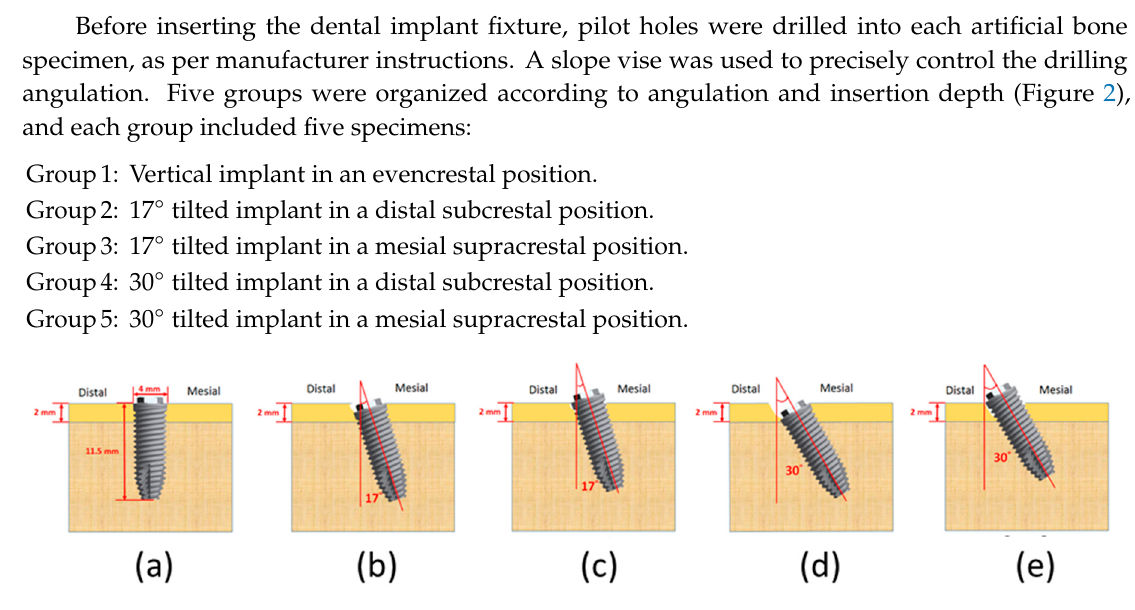
Figure 1. ( a ) Artificial foam bone specimen; ( b ) NobelSpeedy Groovy; ( c ) Multiunit abutments.